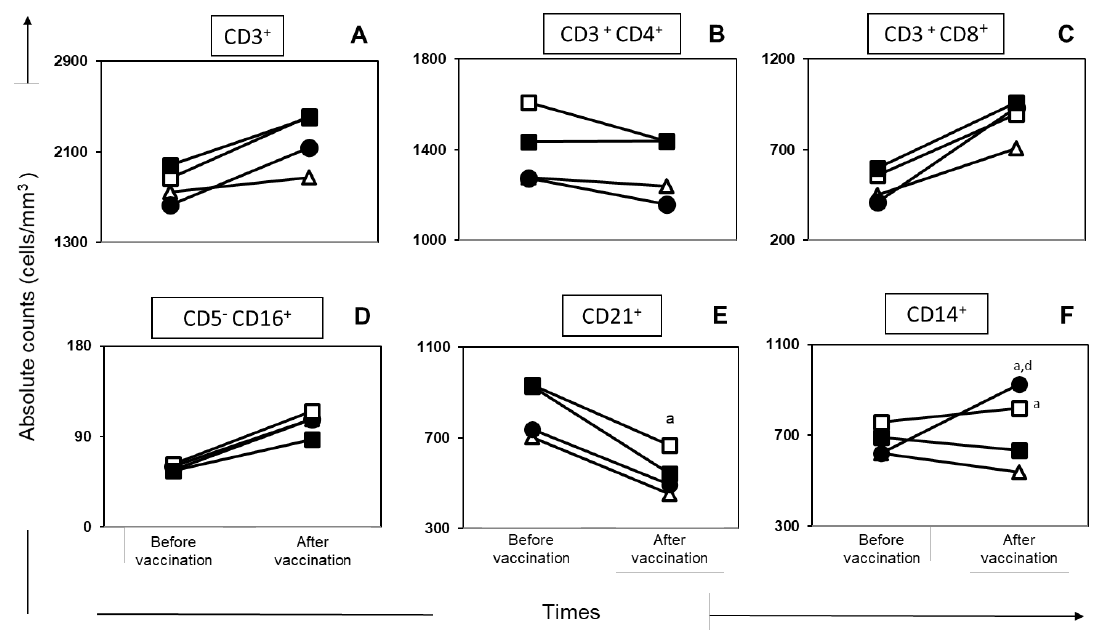
Figure 2. Cellular profile of circulating leukocytes in dogs submitted to different vaccination protocols. C (control; ); LBSap (killed Leishmania braziliensis vaccine plus saponin; ) Leishmune ® ( ); Leish-Tec ® ( ). The x -axis displays the times of the assays (time before vaccination and time after vaccination), and the y -axis represents the mean values of absolute counts: ( A ) CD3 + lymphocytes; ( B ) CD3 + CD4 + lymphocytes; ( C ) CD3 + CD8 + lymphocytes; ( D ) CD5 − CD16 + natural killer cells; ( E ) CD21 + B cells; ( F ) CD14 + monocytes. Significant differences ( p < 0.05) in relation to the C or Leish-Tec® groups are represented by the letters a and d, respectively.